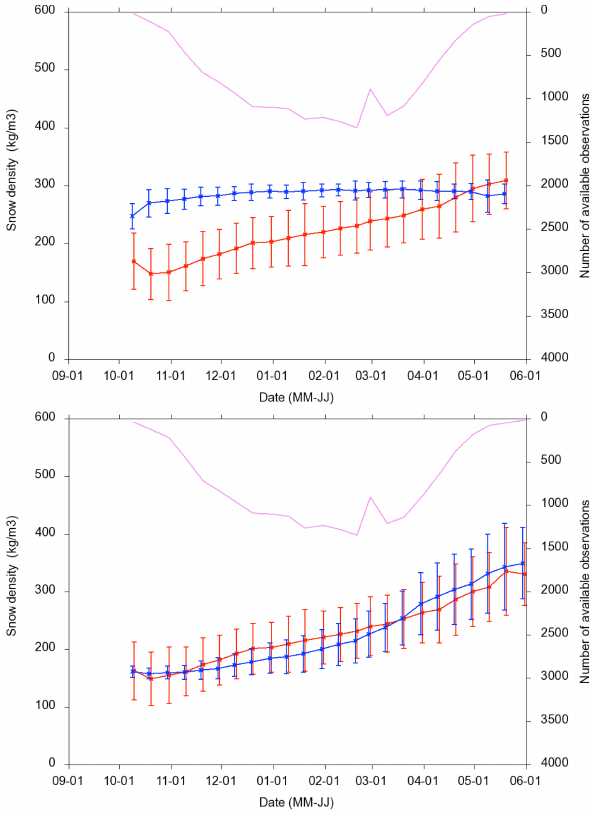
Figure 12. Snow density seasonal evolution as observed (red) and estimated (blue) by ERA-Interim (top panel) and by ERA- Interim/Land (bottom panel). Each point represents the station data from the former USSR, averaged over about 20 points along tran- sects around each station, all stations and all years from 1997 to 1993. The vertical bar indicates ± 1 standard deviation and the pur- ple line indicates the number of observations with the right-hand scale from top to bottom. Observations are only included when both observations and model have snow. The snow season from October to June is considered only.